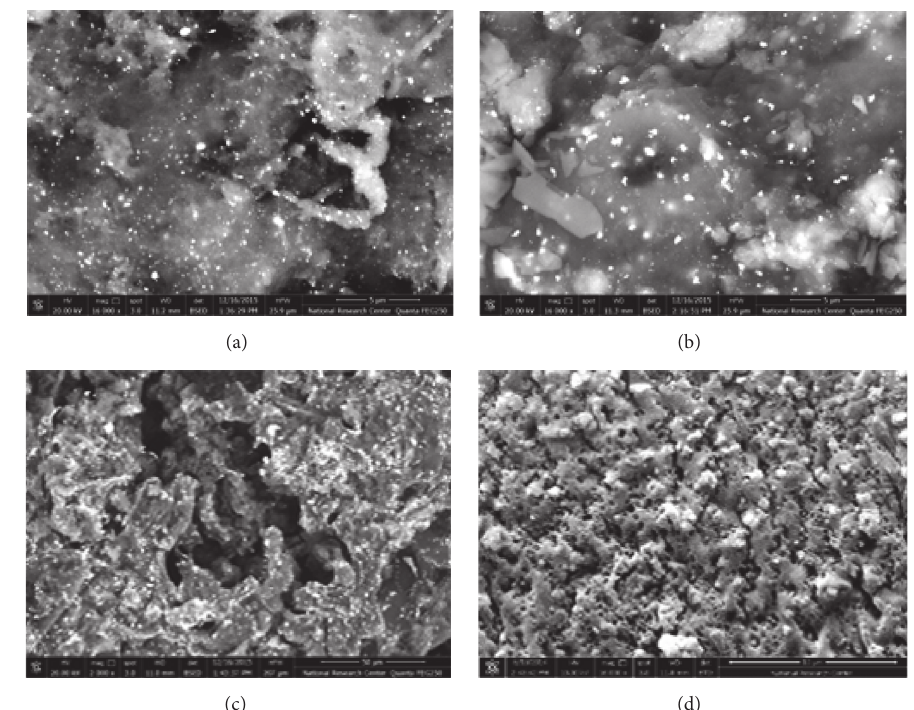
Figure2:SEMof(a)CS/3-methyl-1H-pyrazole-4-carbaldehydeloadedwithAgNPs;(b)CS/1,3-diphenyl-1H-pyrazole-4-carbaldehydeloaded with AgNPs; (c) CMCS/3-methyl-1H-pyrazole-4-carbaldehyde loaded with AgNPs; (d) CMCS/1,3-diphenyl-1H-pyrazole-4-carbaldehyde loaded with